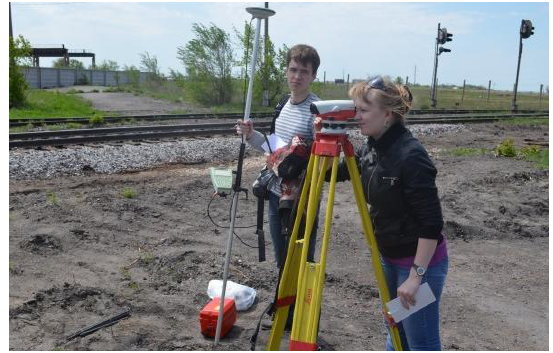
Figure 2. Carrying out of a ground monitoring According to (Monserrat, O., Crosetto, M., Luzi, G., 2014), the